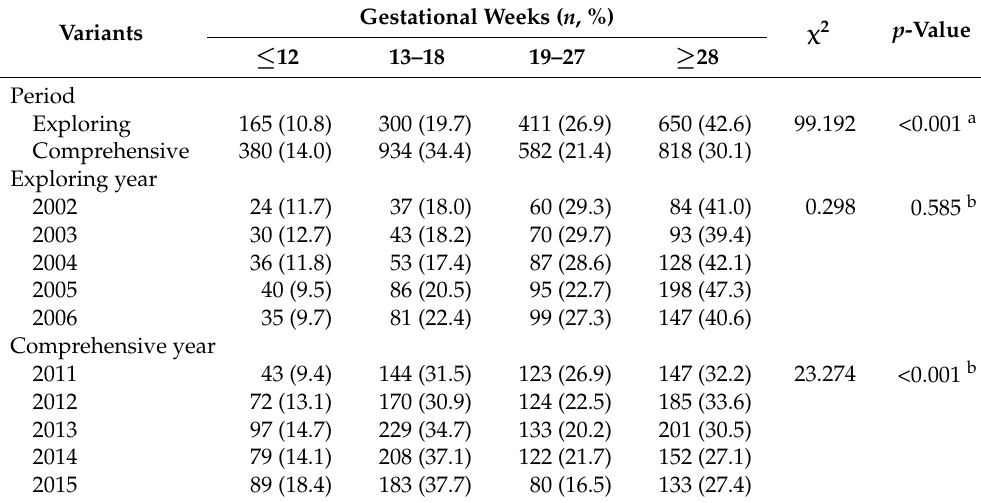
Table 2. Distribution for syphilis screening by gestational weeks in the exploring and the comprehensive period ( n =